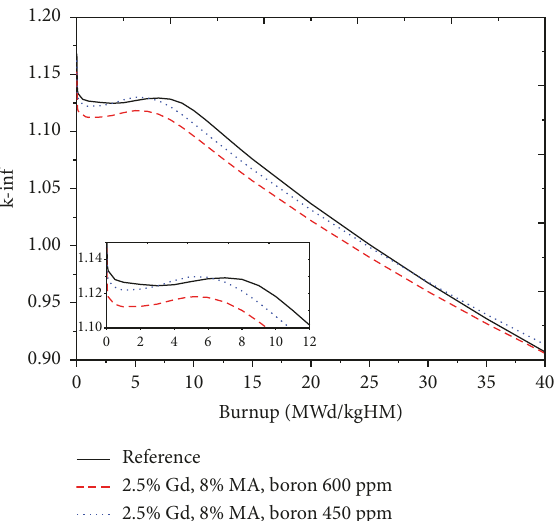
Figure 10: The k-inf versus burnup when loading 6 wt.% of MAs and reducing GD to 3wt.%.